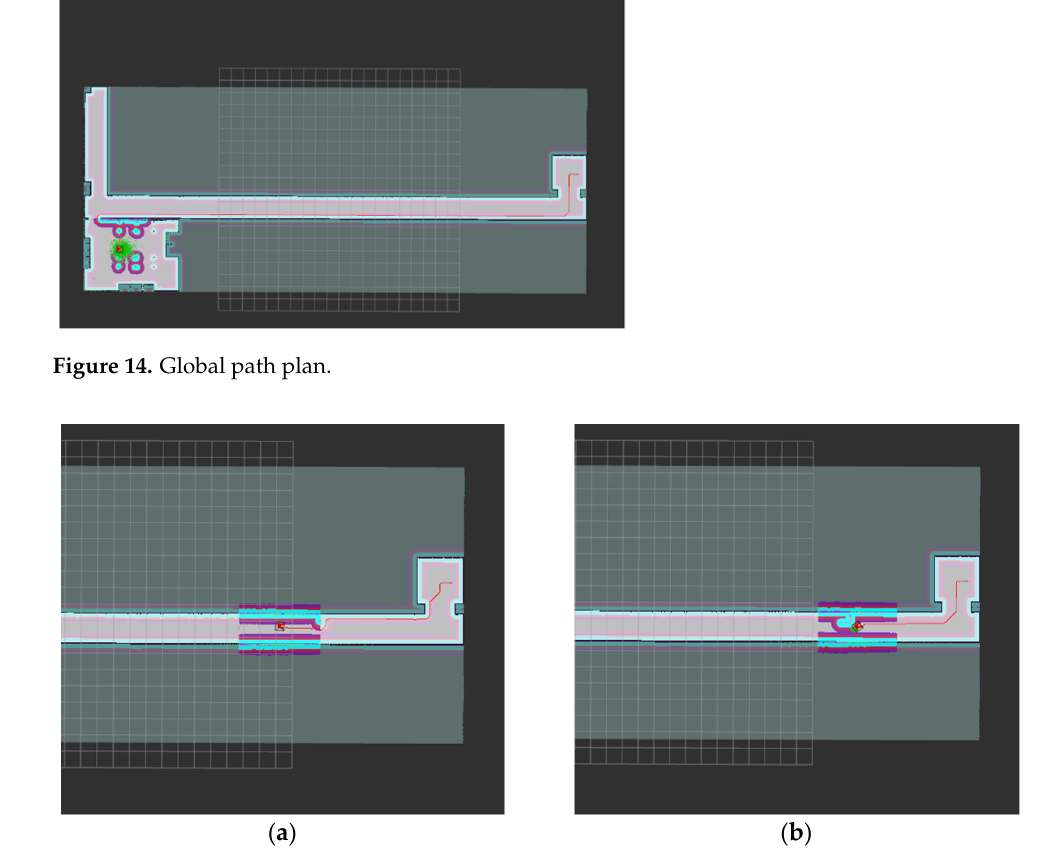
Figure 15. DWA dynamic obstacle avoidance. ( a ) Detect the obstacle; ( b ) Avoid the obstacle. After dynamic obstacle avoidance is completed, the robot continues to move along the planned route. Finally, the robot reaches the target point and the navigation ends, as shown in Figure 16.